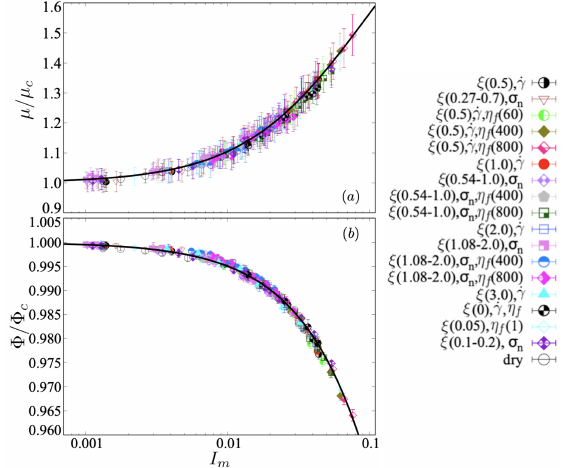
Figure 4. E ↵ ective friction µ and packing fraction  as a func- tion of I m in a sheared packing of wet particles simulated for a broad range of parameters. For each set of simulations, the sym- bols and their colors correspond to the parameters that are varied with their ranges, all other parameters being kept constant